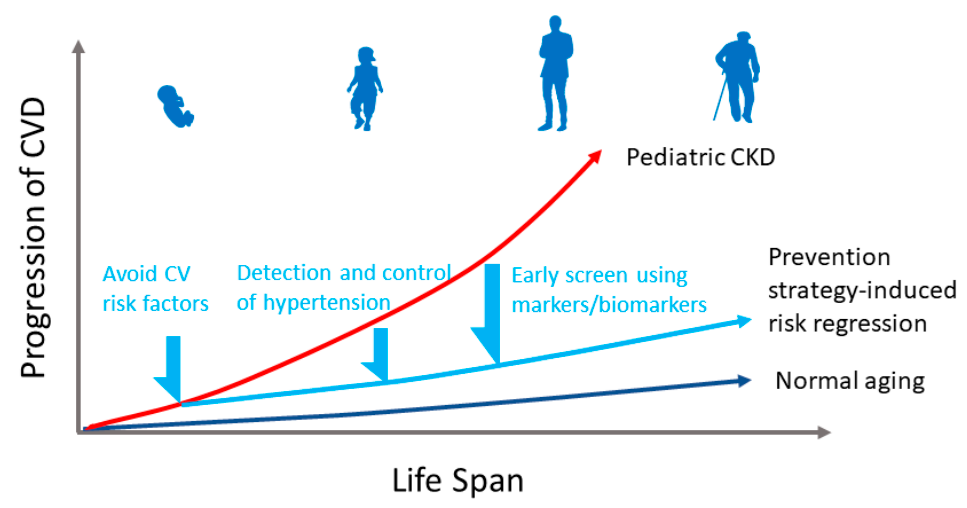
Figure 1. Concept of normal, pediatric chronic kidney disease (CKD) and prevention strategy-induced cardiovascular (CVD) across the lifespan. Avoid cardiovascular risk factors, detection and control hypertension, and screening using markers/biomarkers early in life allows for timely detection of subclinical CVD and initiation of treatment strategies to avert CVD in later life.